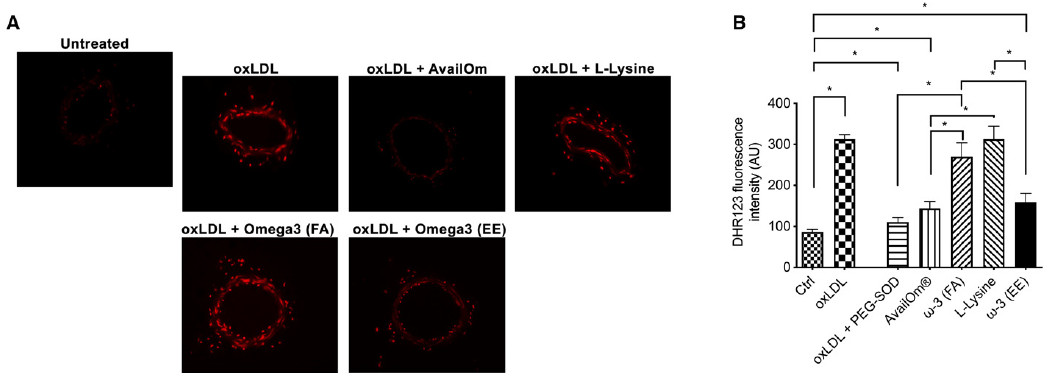
Figure 3. Effect of AvailOm ® in vascular oxidative stress and endothelial dysfunction induced by oxLDL. ( A ) Representative high-power micrographs of mice mesenteric arteries cryosections loaded with 5 µ M of dihydroethidium dye. Mesenteric arteries were pre-treated with a single compound (100 µg/mL) for 1 h and then stimulated with oxLDL for 30 min before the acquisition. ( B ) Measurement of ROS production by DHR123 in vessels treated with single compounds. AU, arbitrary units. Statistical analyses were performed using one-way ANOVA followed by Bonferroni post hoc test. * p < 0.05